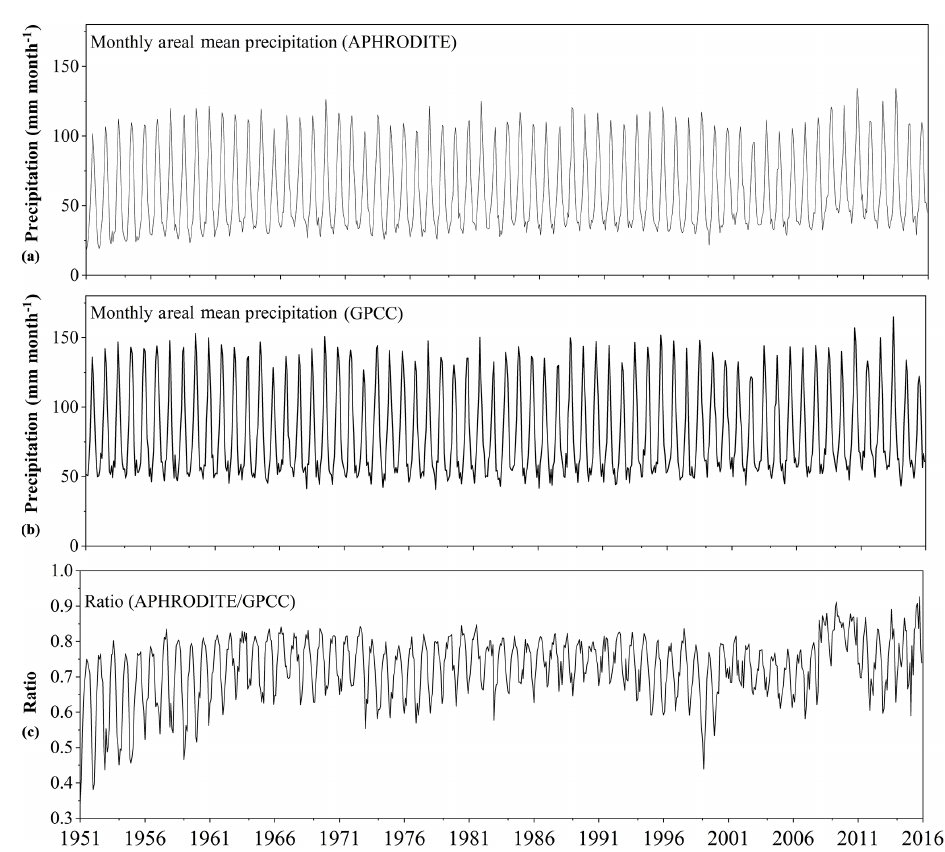
Figure 14. The temporal patterns of monthly areal mean precipitation of (a) APHRODITE and (b) GPCC and monthly (c) ratio values of corresponding areal mean APHRODITE/GPCC,